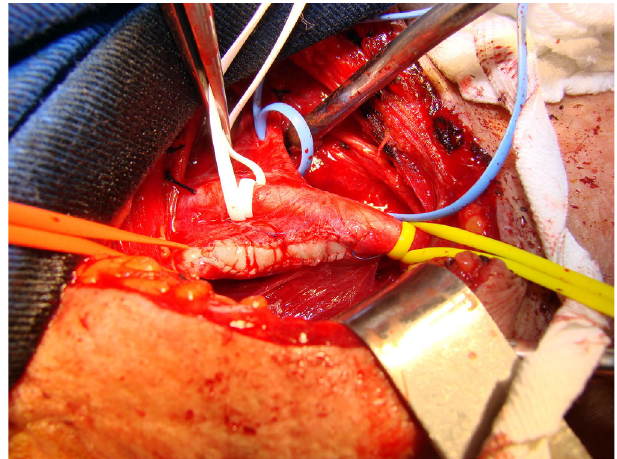
Fig. 4 - Closing the internal carotid artery with elliptical patch of